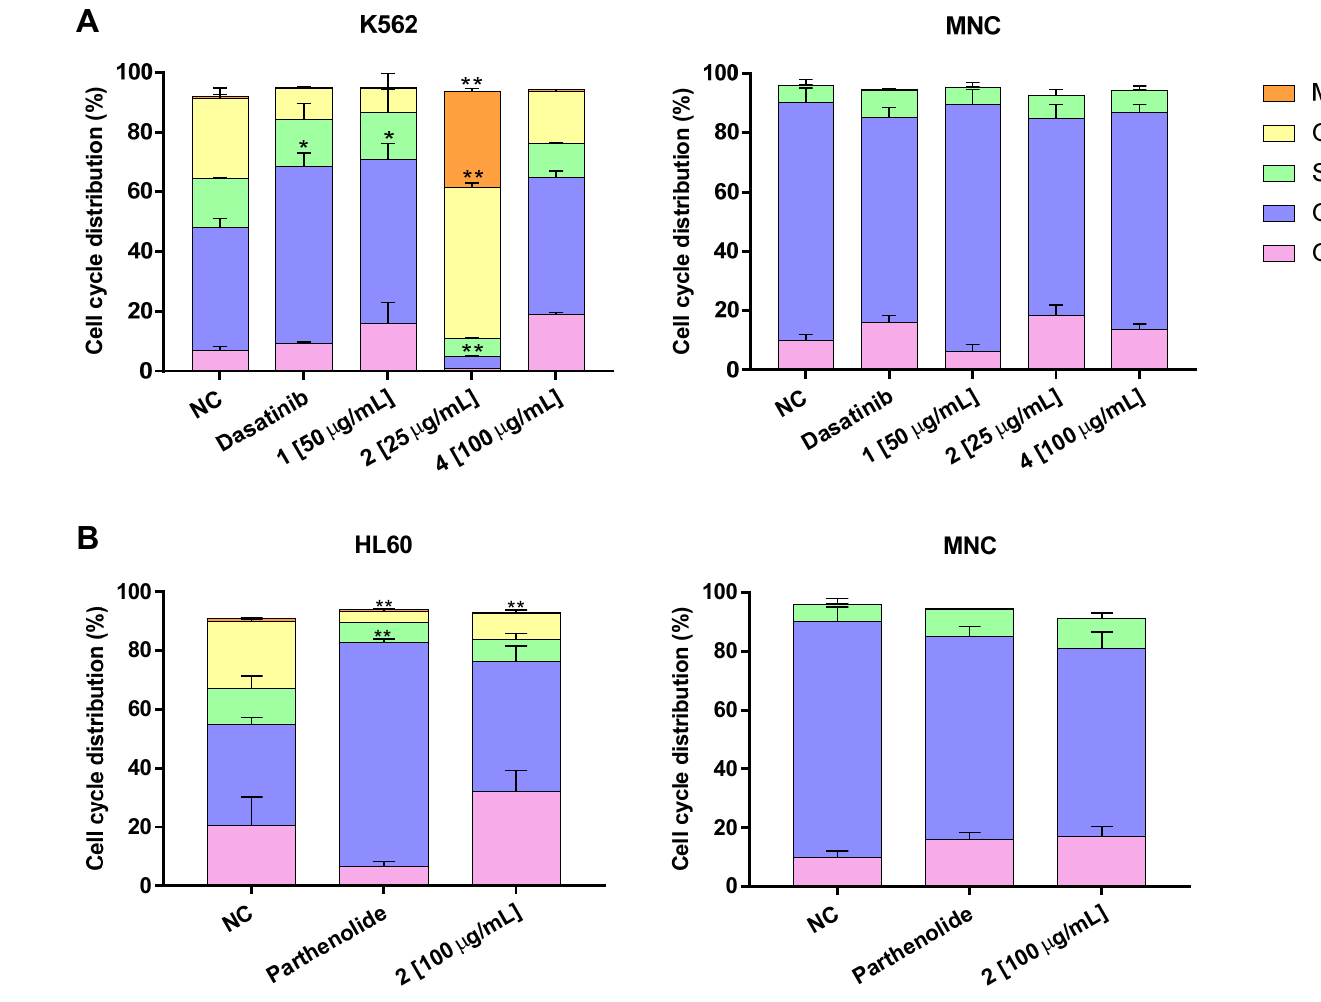
Figure 5. Results in cells K562 ( A ) and HL60 ( B ) of different compounds on the cell cycle status, represent mean ± SEM from three different experiments of cell cycle phase distribution in the different cells analyzed. Significance between cell cycle phase was determined using one-way analysis of variance (ANOVA) followed by Dunnett’s post-hoc test . Differences were considered significant at * p < 0.05, ** p < 0.01 vs. negative control (NC).